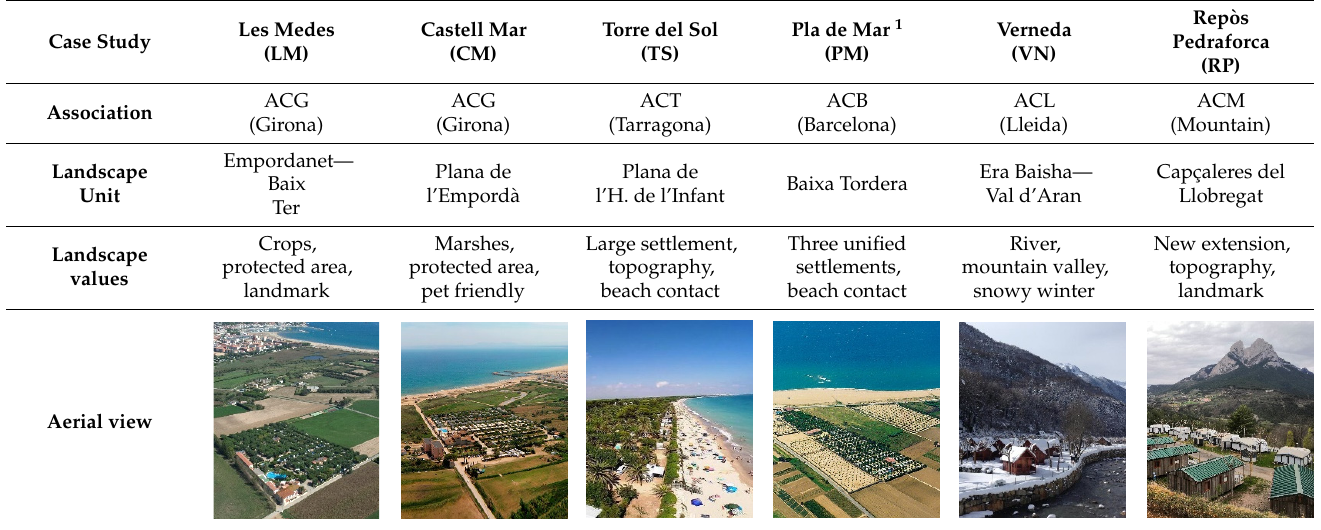
Figure 1. Location of the selected case studies and distribution of campsite associations in Catalonia (Source: authors’ own). ( A ) Campsite Les Medes; ( B ) Campsite Castell Mar; ( C ) Campsite Torre del Sol; ( D ) Campsite Pla de Mar; ( E ) Campsite Verneda; ( F ) Campsite Rep ò s Pedraforca. Table 2. Identification of selected case